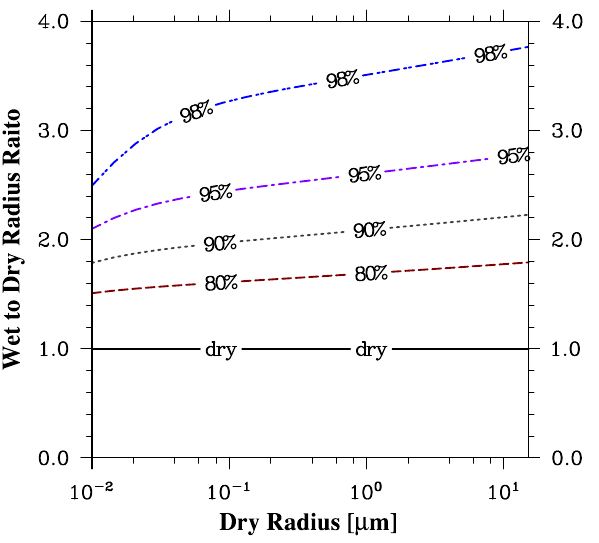
Fig. 4. The ratio of wet to dry radius at different relative humidity values using Gerber (1985).